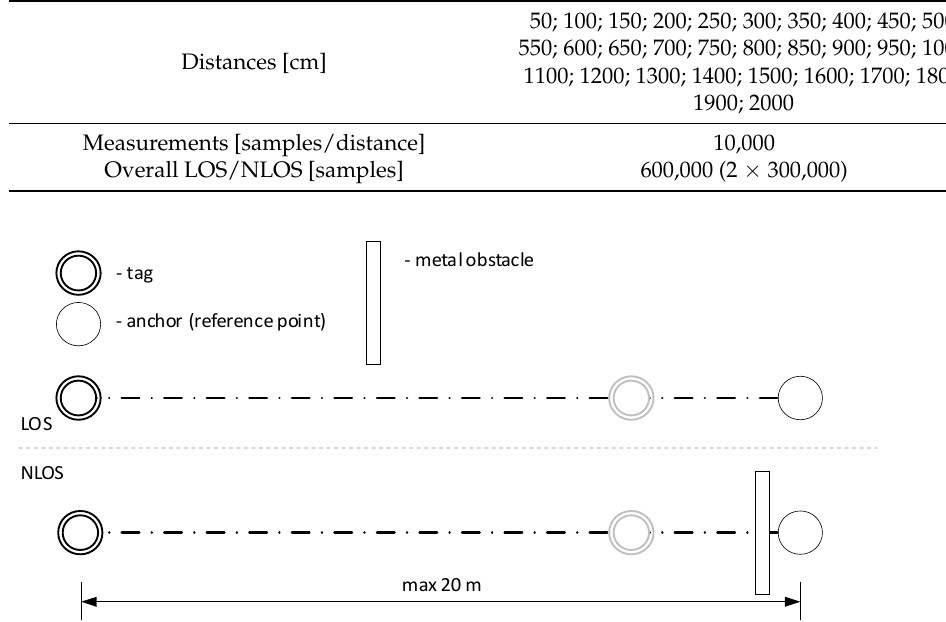
Figure 2. Test stand for static distance measurements (in both LOS and NLOS conditions).